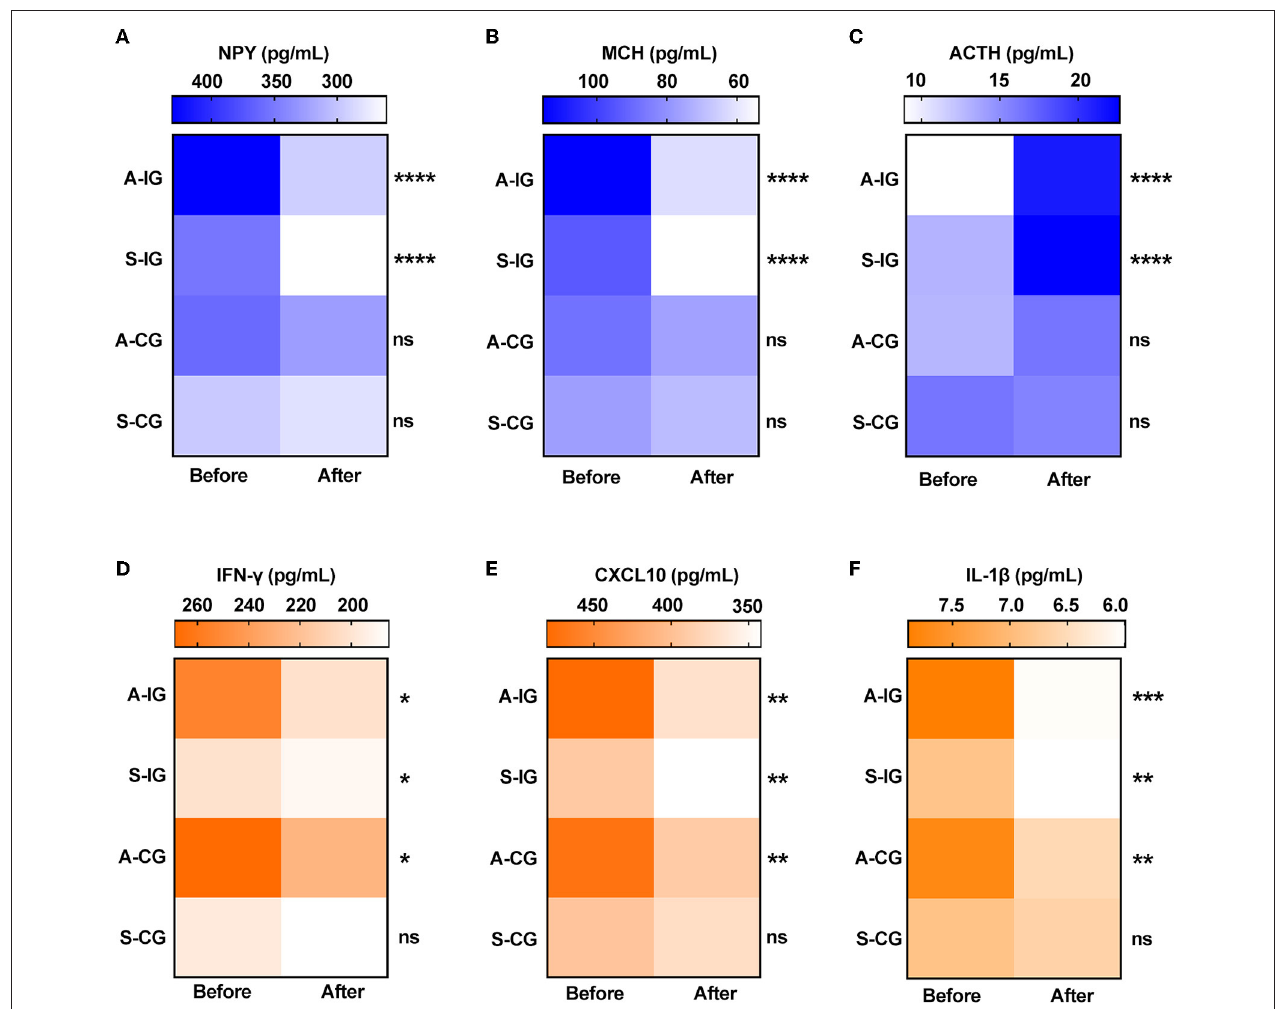
FIGURE 4 | Serum levels of neuropeptides and cytokines before and after 4 weeks in the two groups. (A) NPY, (B) MCH, (C) ACTH, (D) IFN- γ , (E) CXCL10, and (F) IL-1 β . A-IG, active phase of intervention group; S-IG, stable phase of intervention group; A-CG, active phase of control group; S-IG, stable phase of control group. * P < 0.05, ** P < 0.01, *** P < 0.001, **** P < 0.0001, ns,